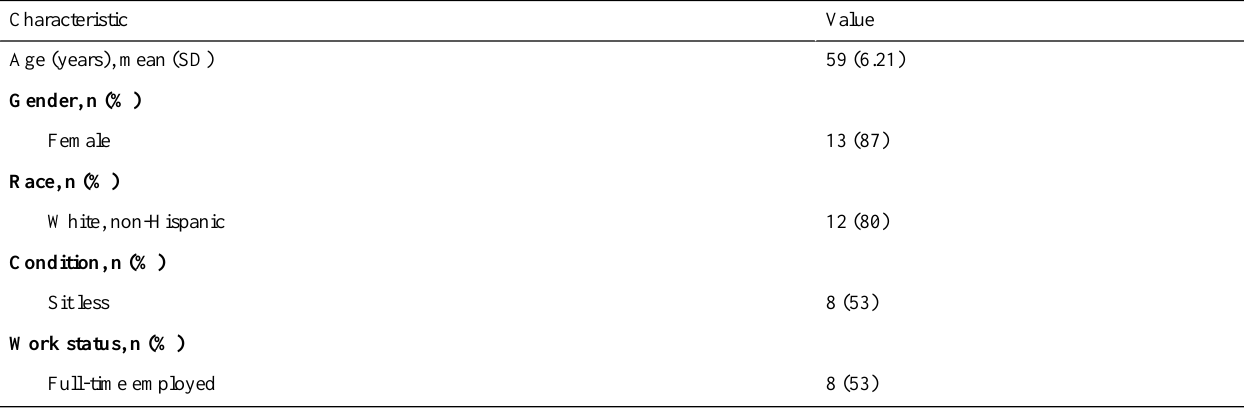
Table 2. Descriptive statistics for participants in the focus groups (N=15).